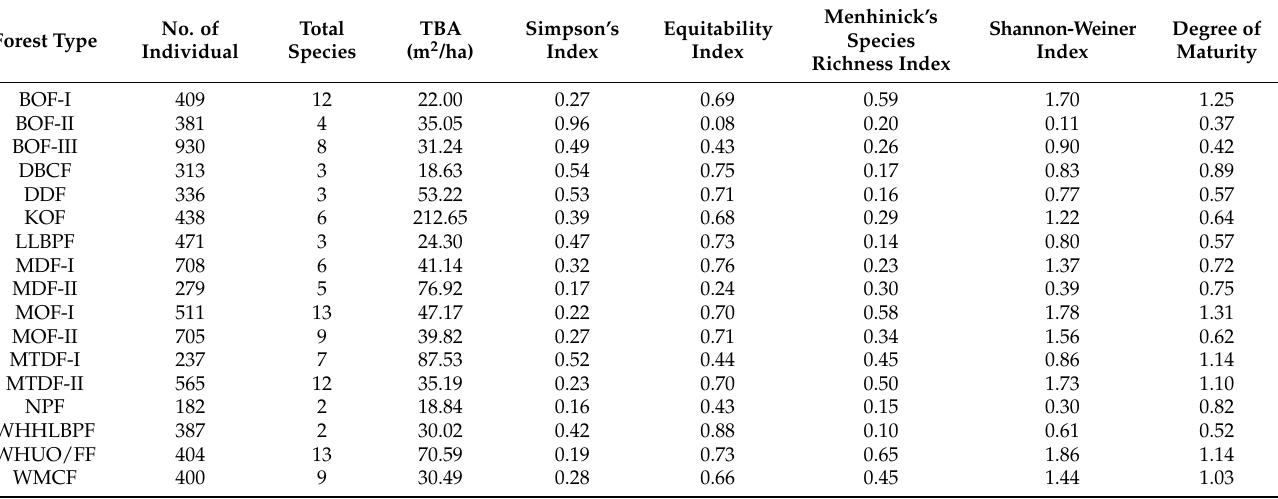
Table 1. Community attributes of different Himalayan temperate